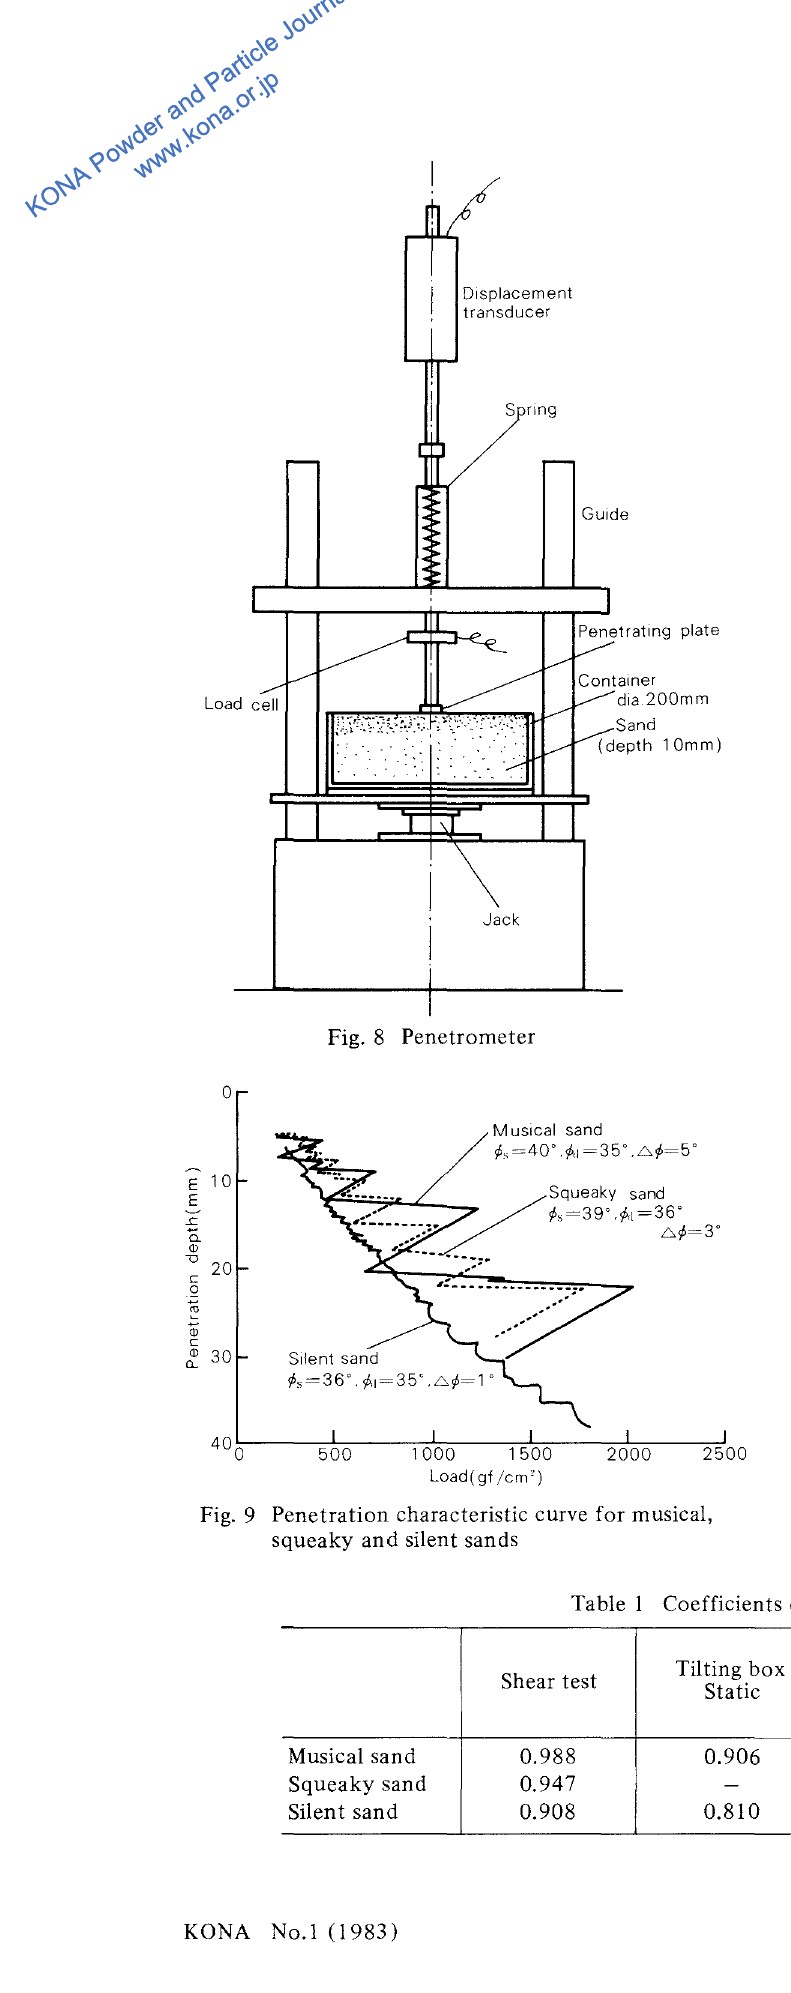
Fig. 9 Penetration characteristic curve for musical, squeaky and silent